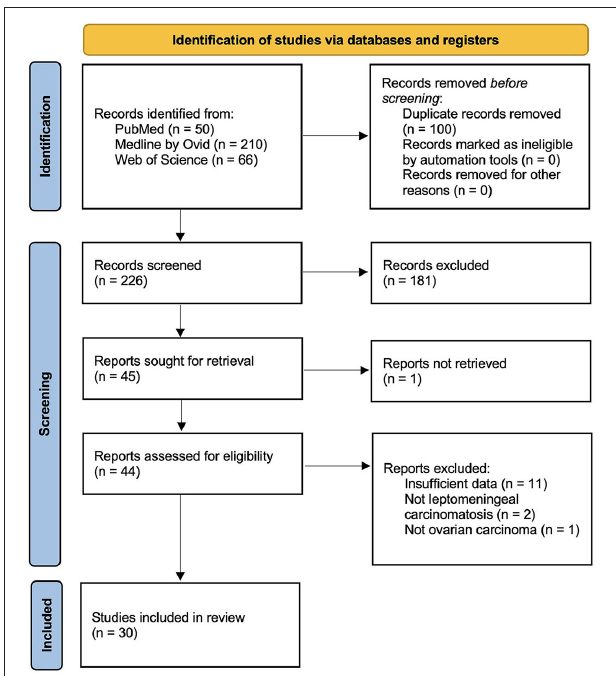
FIGURE 4 | PRISMA study selection flowsheet for systematic review of the literature pertaining to leptomeningeal carcinomatosis of ovarian origin.